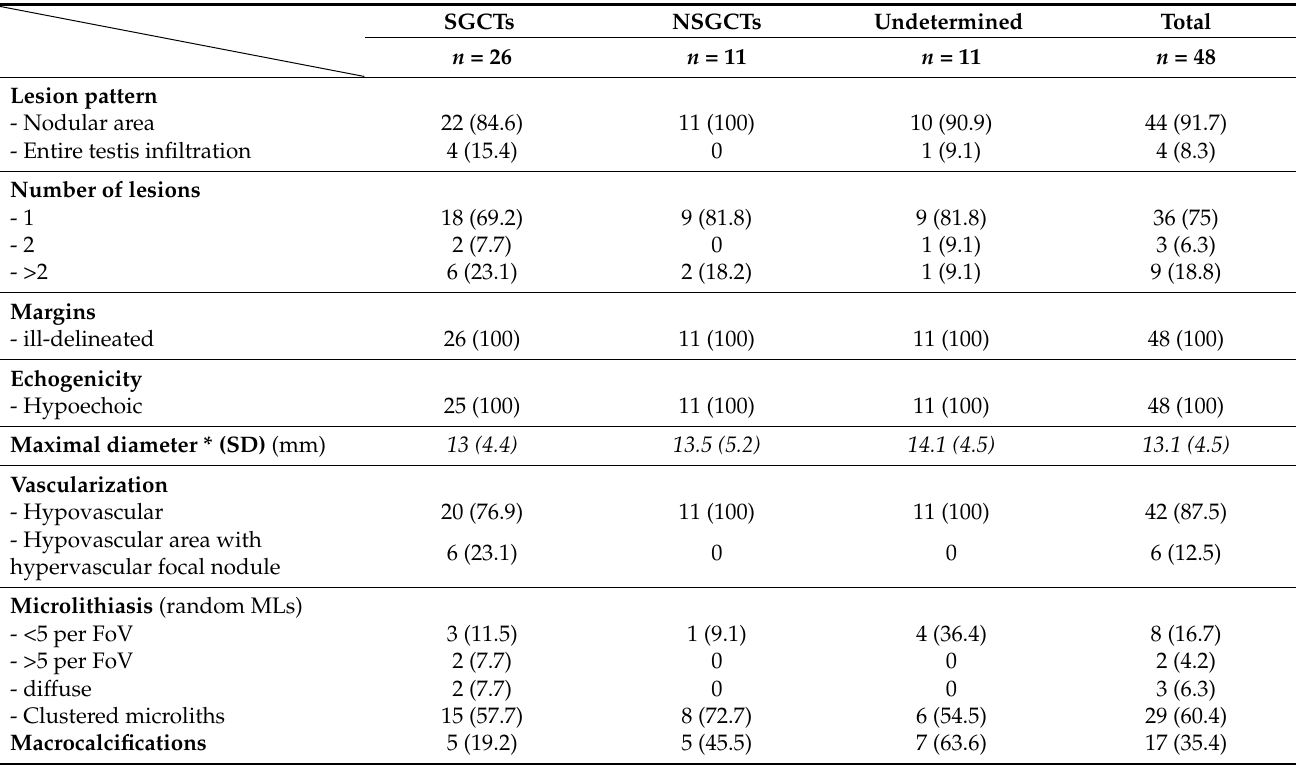
Table 2. Conventional US